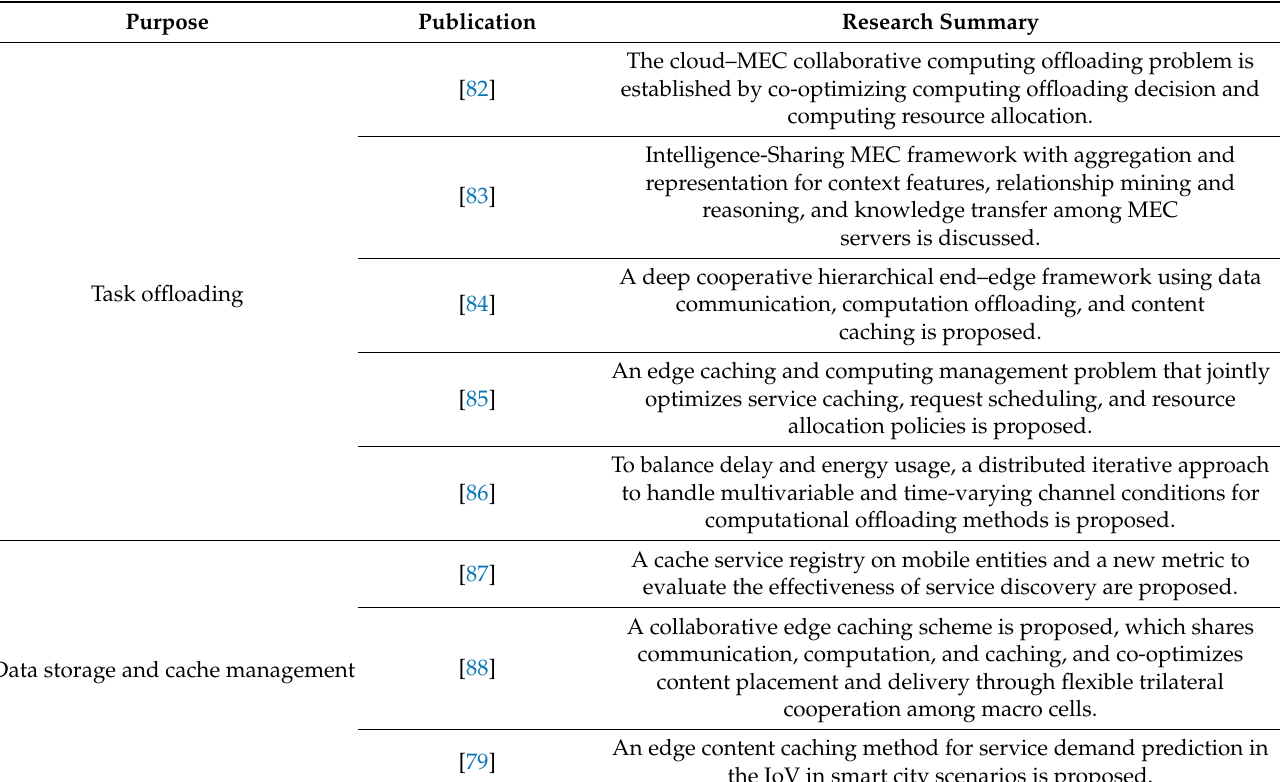
Table 4. Recent studies on Collaborative Computing in